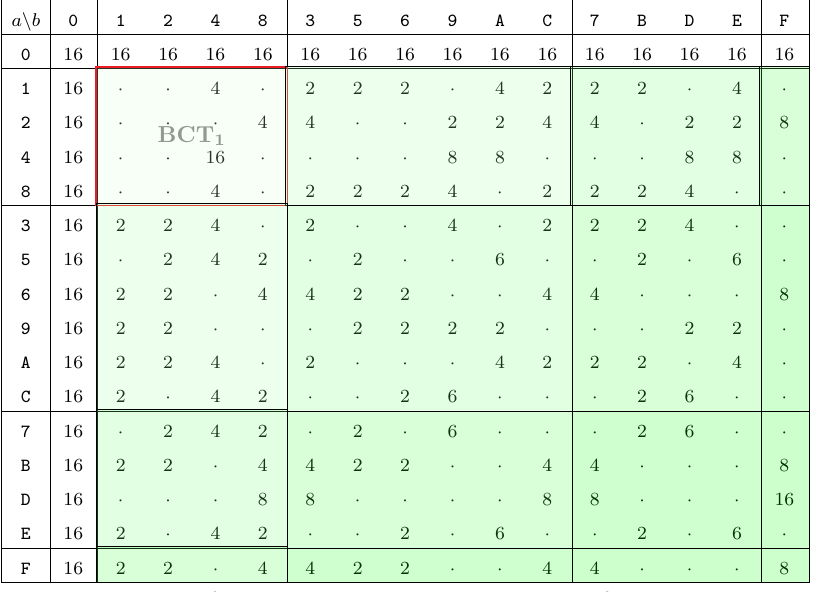
Figure 4: The BCT of the Serpent S-boxes S